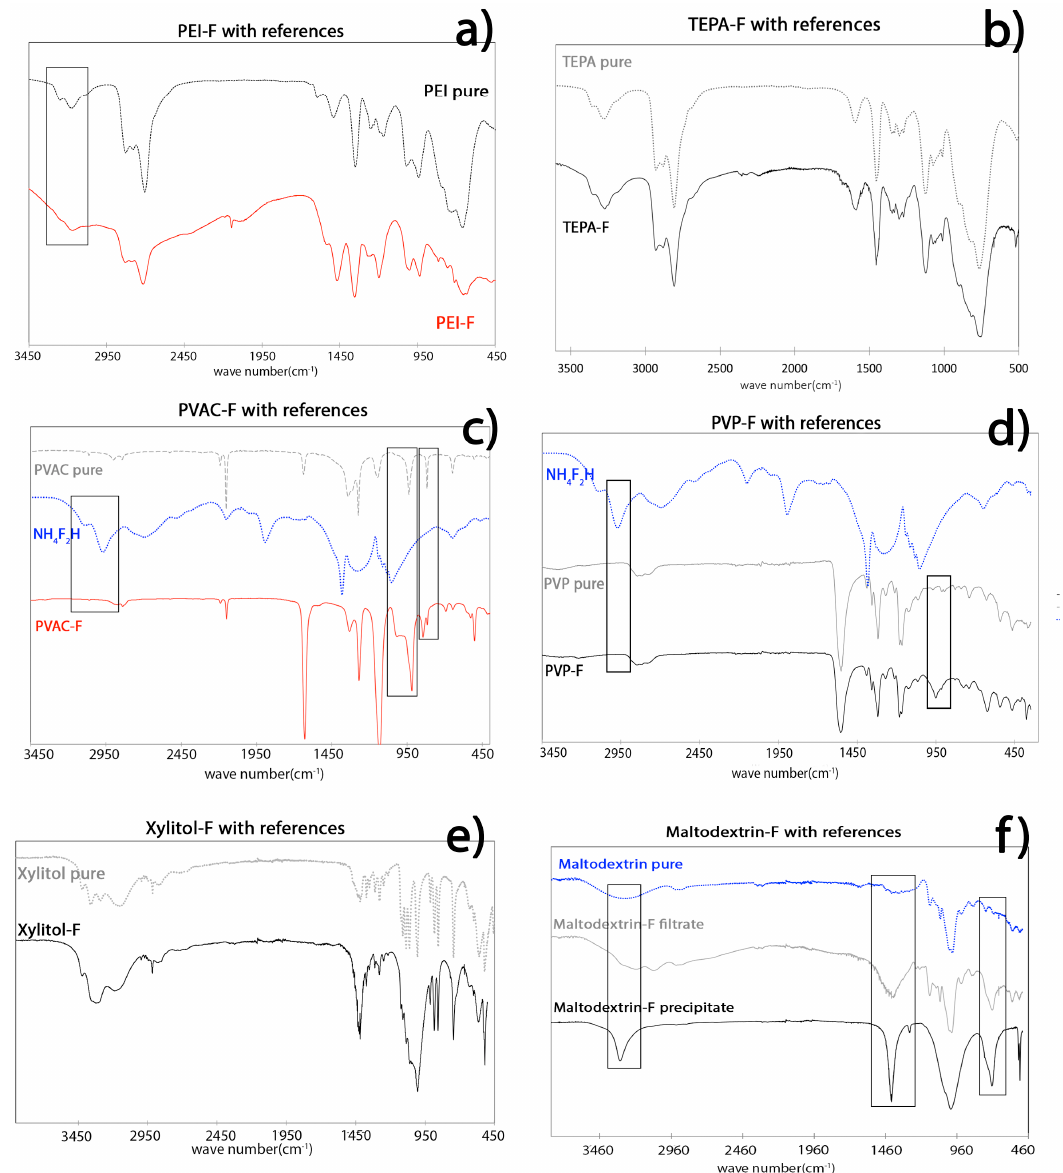
Figure 4. IR spectra of: TEPA-F ( a ); PEI-F ( b ); PVAC-F ( c ); PVP-F ( d ); Xy-F ( e ); and Malto-F ( f ).